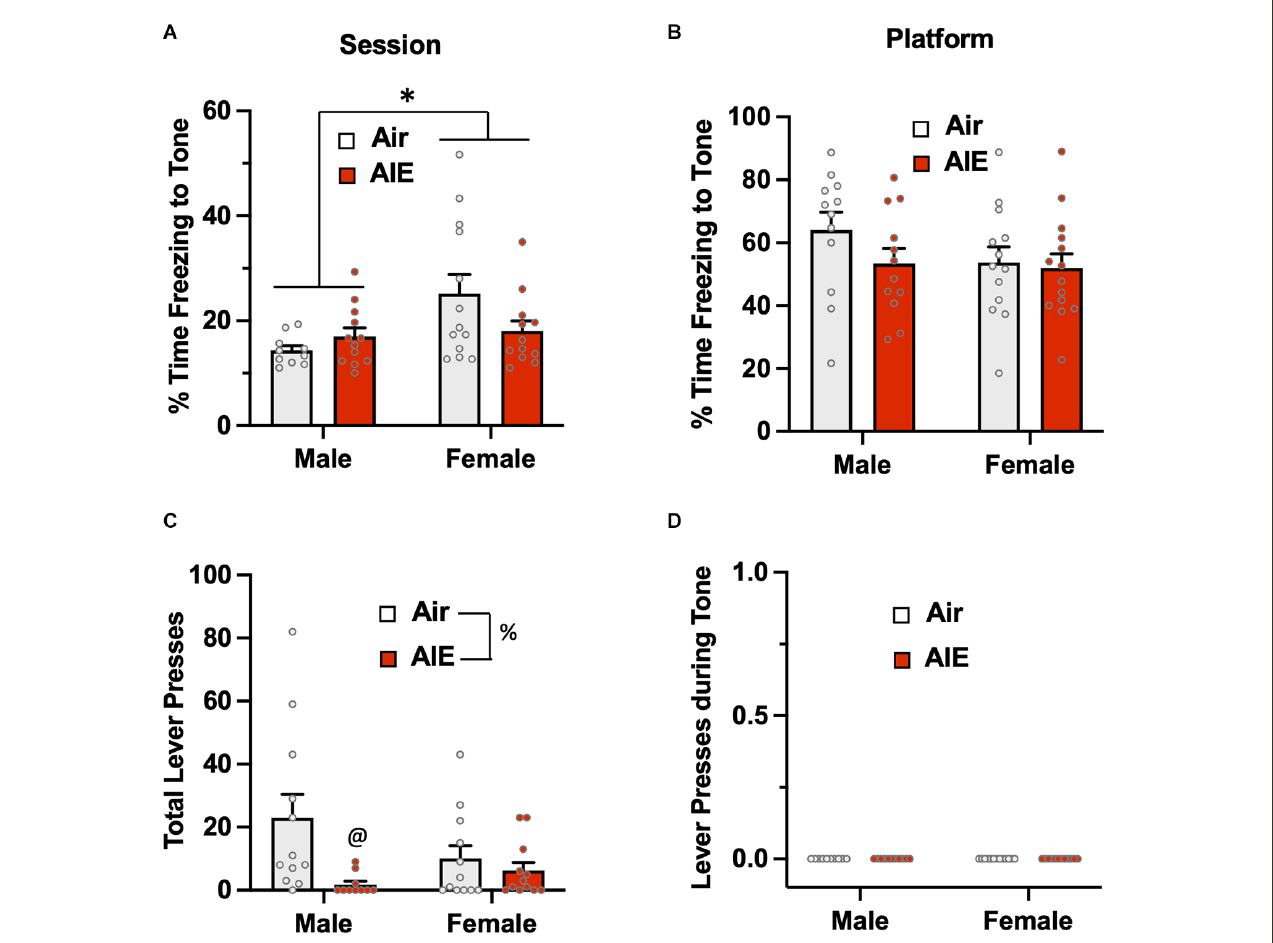
FIGURE3 Freezing behavior and lever pressing assessed on the test day of the platform-mediated avoidance task. (A) When freezing to the tone on the test day was examined irrespective of location, female rats exhibited higher levels of freezing compared to the male rats. AIE exposure did not significantly alter freezing in either sex. (B) When analysis of freezing to the tone was restricted to when the rats were positioned on the platform, the sex difference in freezing was no longer observed. (C) Examination of lever responding during the test session revealed total lever pressing by AIE-exposed male rats was significantly reduced. (D) No lever pressing during the tone was observed. Data represent the means ± sem ( n = 12–13/group). ∗ indicates significant main effect of sex, p = 0.02; @ indicates significant difference from the male Air rats, p = 0.010; % indicates significant main effect of AIE, p =